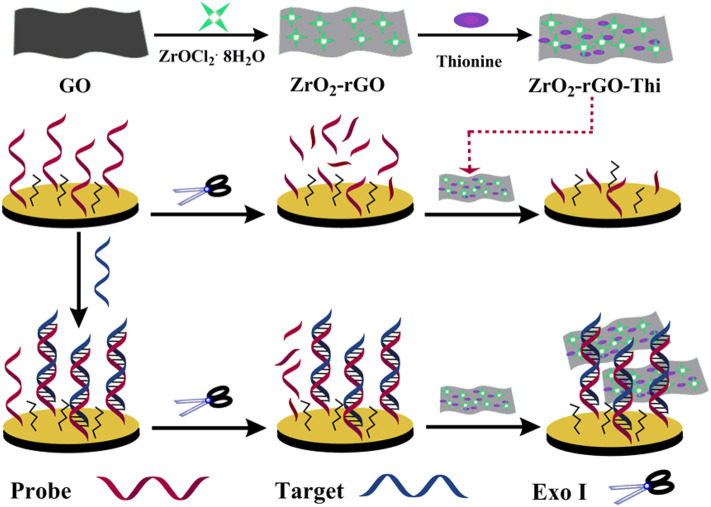
Schematic illustration of electrochemical nucleic acid fabrication by ZrO2-rGO-Thi nanocomposite.